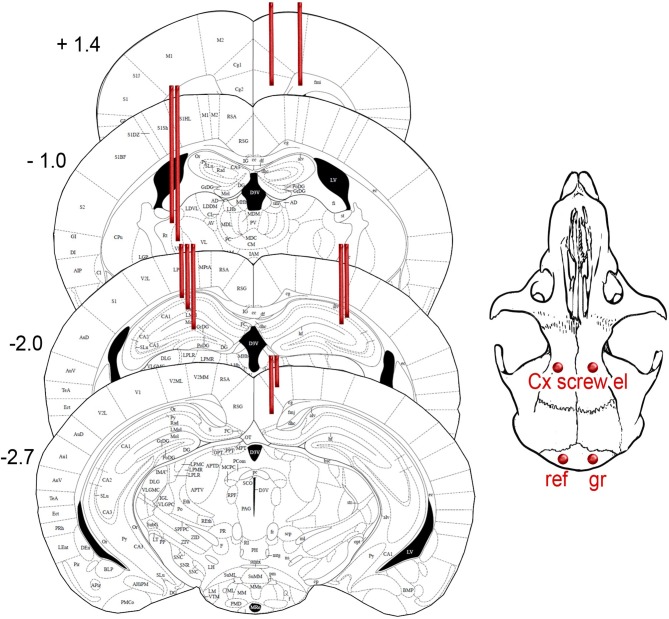
Schematic drawing of the intended location of 15 recording electrodes projected on the closest atlas graphs (18). The coordinates and distance from bregma. The exact location of electrodes in individual mice is summarized in Table 1.